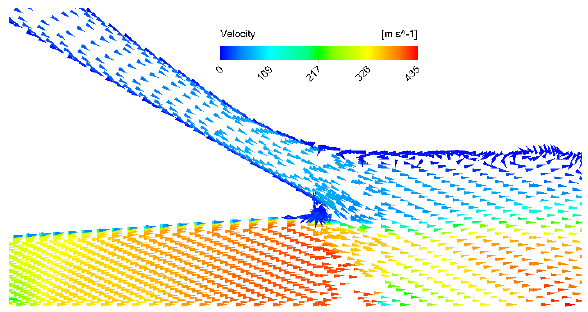
Fig. 13. Vectors of velocity magnitude for relative back- pressure p 4 /p 02 = 1.57, (152 kPa abs) in the vicinity of the motive nozzle.